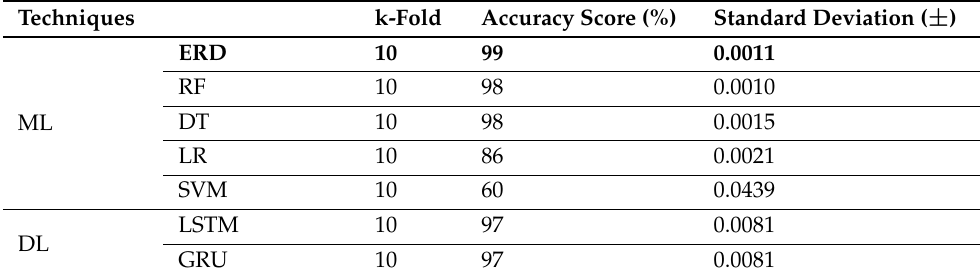
Table 7. k-fold cross validation analysis of the applied machine and deep learning